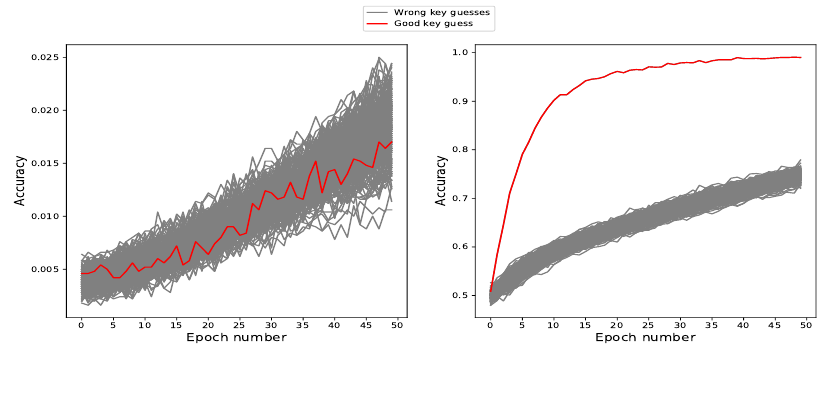
Figure 7: MLP-DDLA accuracies using two different labeling methods. Left: Identity labeling. Right: Binary labeling